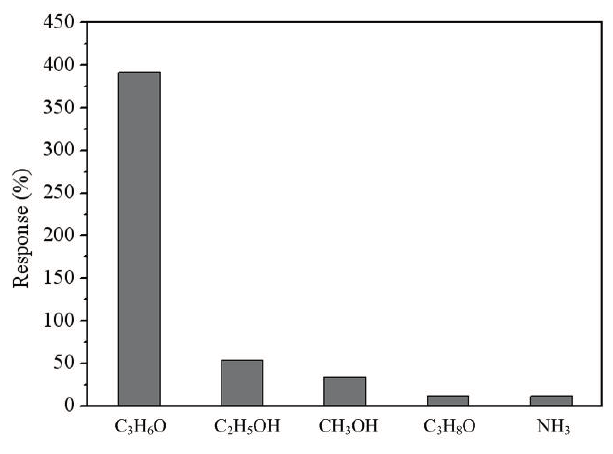
Figure 17. Response of the sensor under different